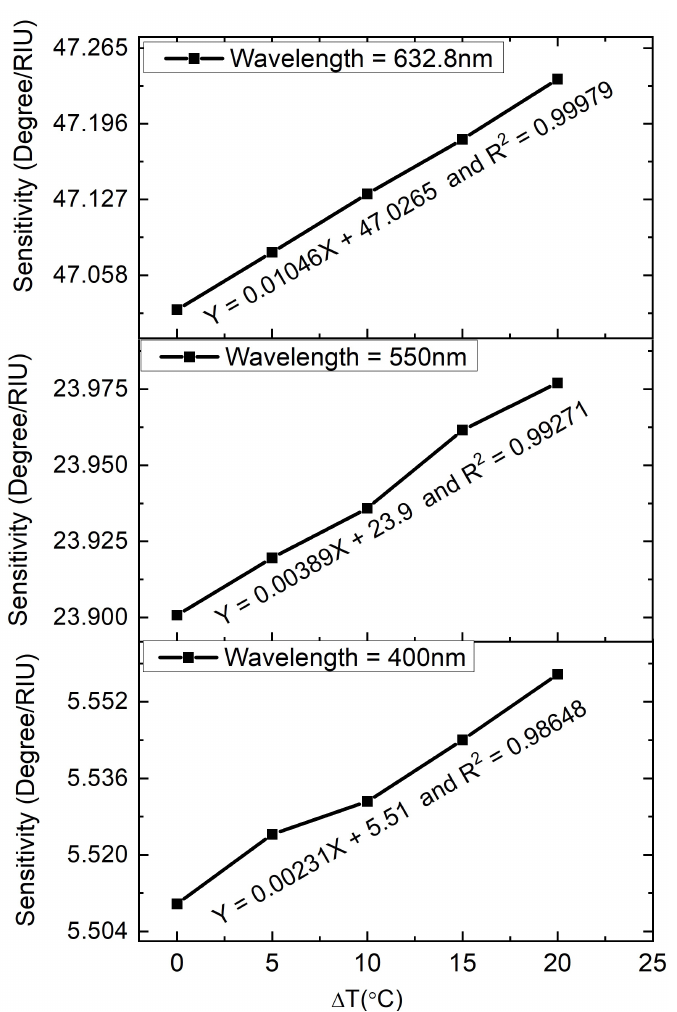
Figure 7. Linear plot of temperature dependent sensitivity comparison at incident wavelengths of 400 nm, 550 nm and 632.8